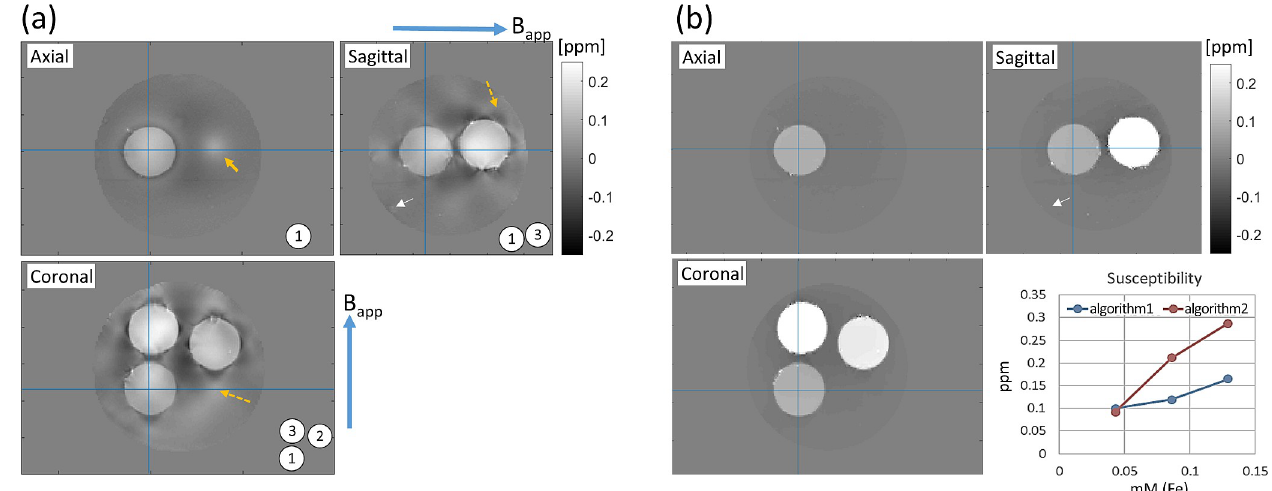
Fig 6. 3-plane quantitative susceptibility maps of the phantom processed with algorithm 1 (a) and 2 (b) . In (a), streaking artifacts are apparent on the coronal and sagittal planes (orange dashed arrows), giving rise to artificial susceptibility elevation on the axial plane (orange arrow). In both (a) and (b), phase due to the phantom stand produced little susceptibility artifact (white arrows on sagittal planes). The inset of (b) shows the mean susceptibilities of the three inclusions for each processing method. Numerical values and linear fit results are listed in S6 File.